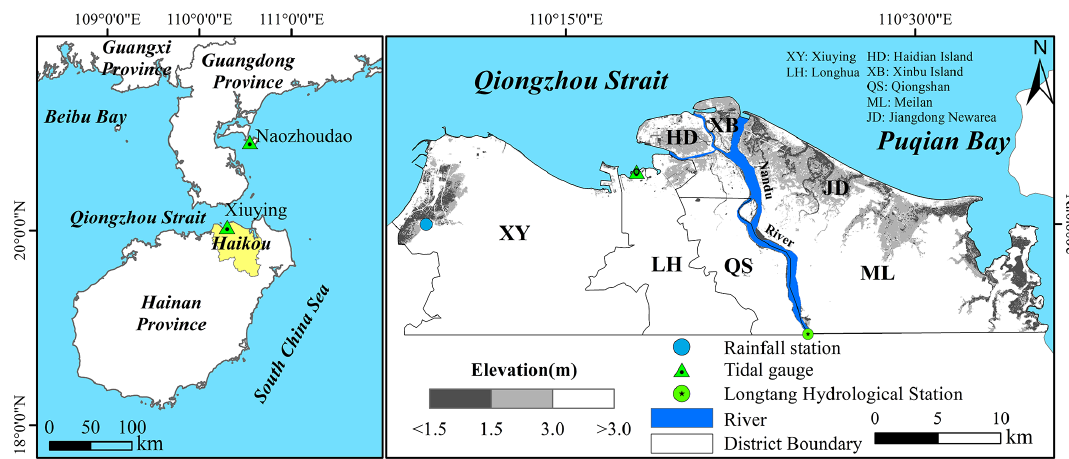
Figure 1. The geographic location of tide stations and Nandu River in Haikou and the basic geographic information of Haikou. Table 1. Data profile of this